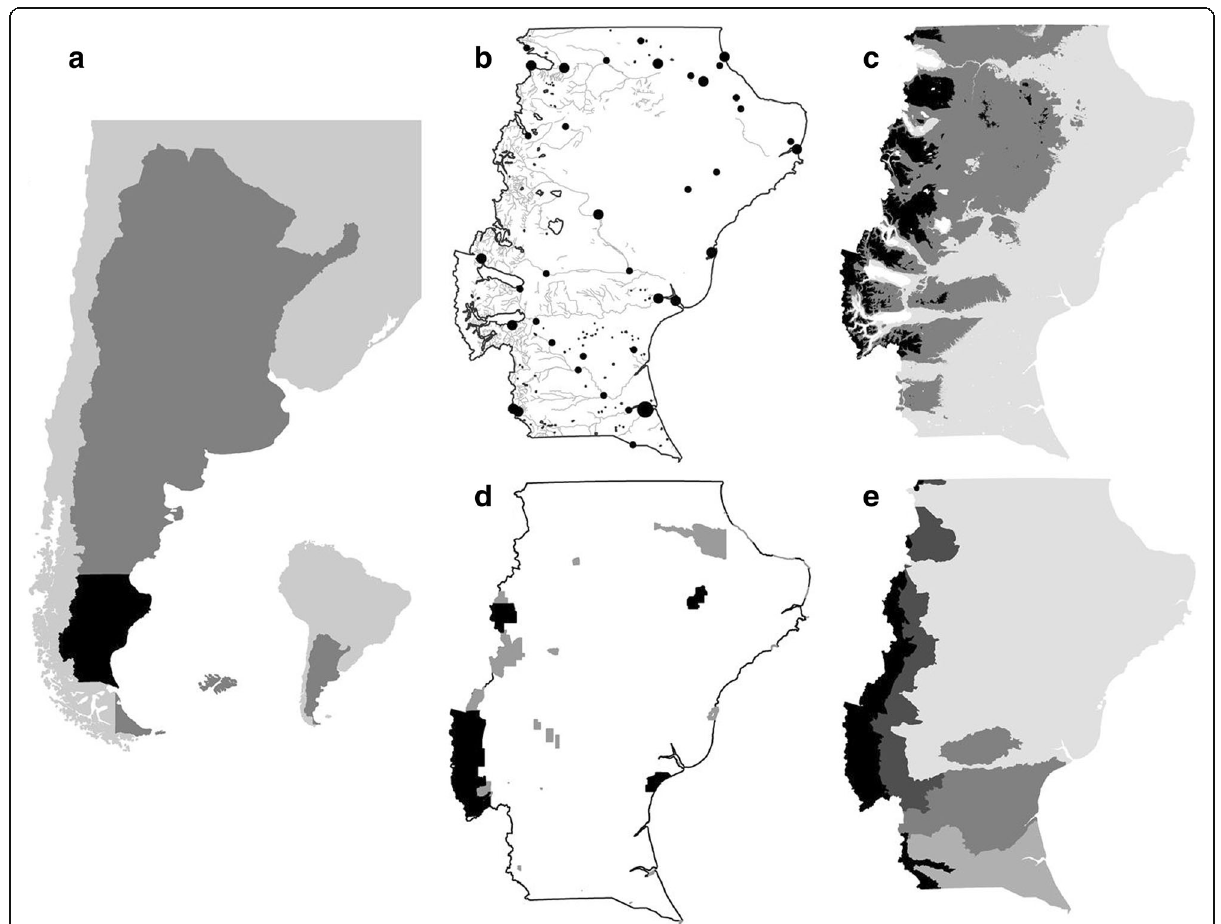
Fig. 1 Characteristics of the study area: a location of Argentina ( dark gray ) and Santa Cruz province ( black ); b towns ( big dot = capital city, middle dot = towns >3000, small dot = towns <3000 inhabitants), lakes and rivers; c relief ( gray = <400, dark gray = 400 – 1000, black = >1000 m.a.s.l.); d protection areas ( gray = provincial reserves, black = national parks); and e main ecological areas ( light gray = dry steppe, gray = humid steppe, medium gray = shrublands, dark gray = sub-Andean grasslands, black = forests and alpine vegetation) (modified from Oliva et al.